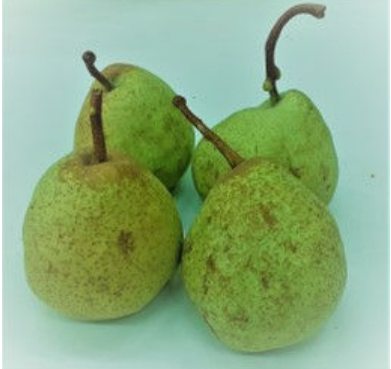
Figure 3. Fruits of Spadona cultivar to be harvested in early October.